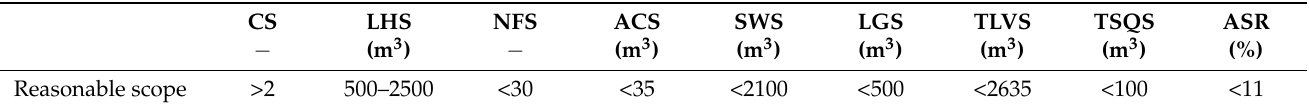
Table 4. Data conformation